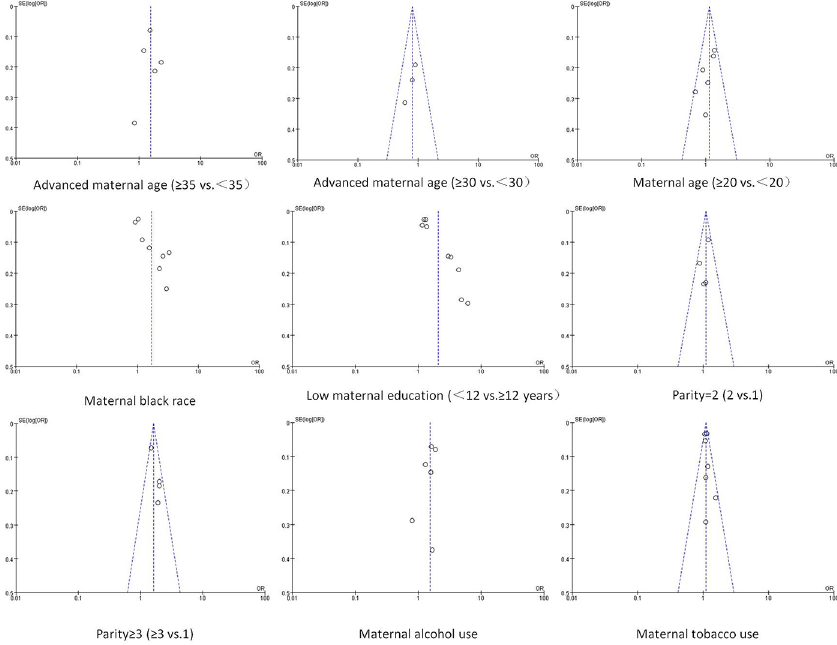
Fig 2. Funnel plot for publication bias test. The two oblique lines indicate the pseudo 95% confidence limits.